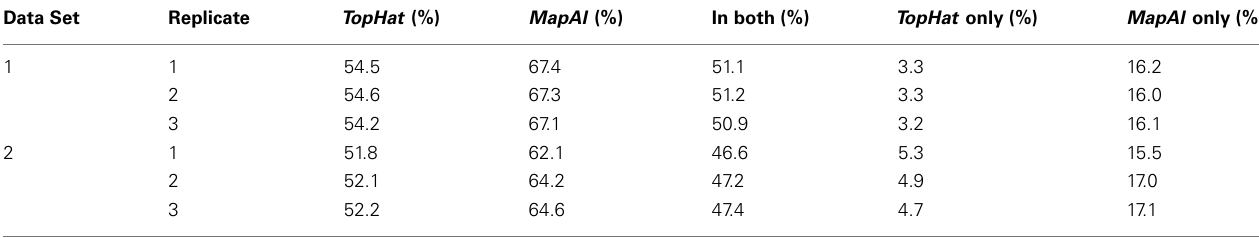
FIGUREA3 | Exemplary gene models. Schematic diagrams presents three example gene models.The top row displays a hypothetical coverage assuming a uniform distribution of reads falling entirely within the exons. The models (A–C) exhibit increasing complexity. In the first model, it is still possible to assess the expression of alternative splice forms even without reads covering exon junctions. Additional junction spanning reads will moderately affect expression level estimates. In the next model, adding